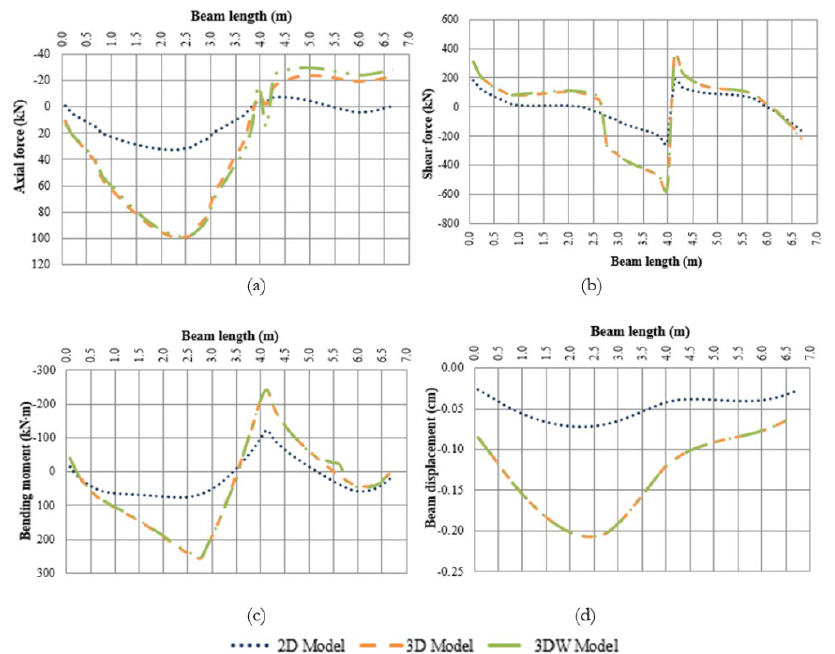
Figure 11. Forces on the support beam of Wall 30 disregarding the load of Beam B4 in the 2D model: (a) Axial force; (b) Shear force; (c) Bending moment; and (d) Vertical